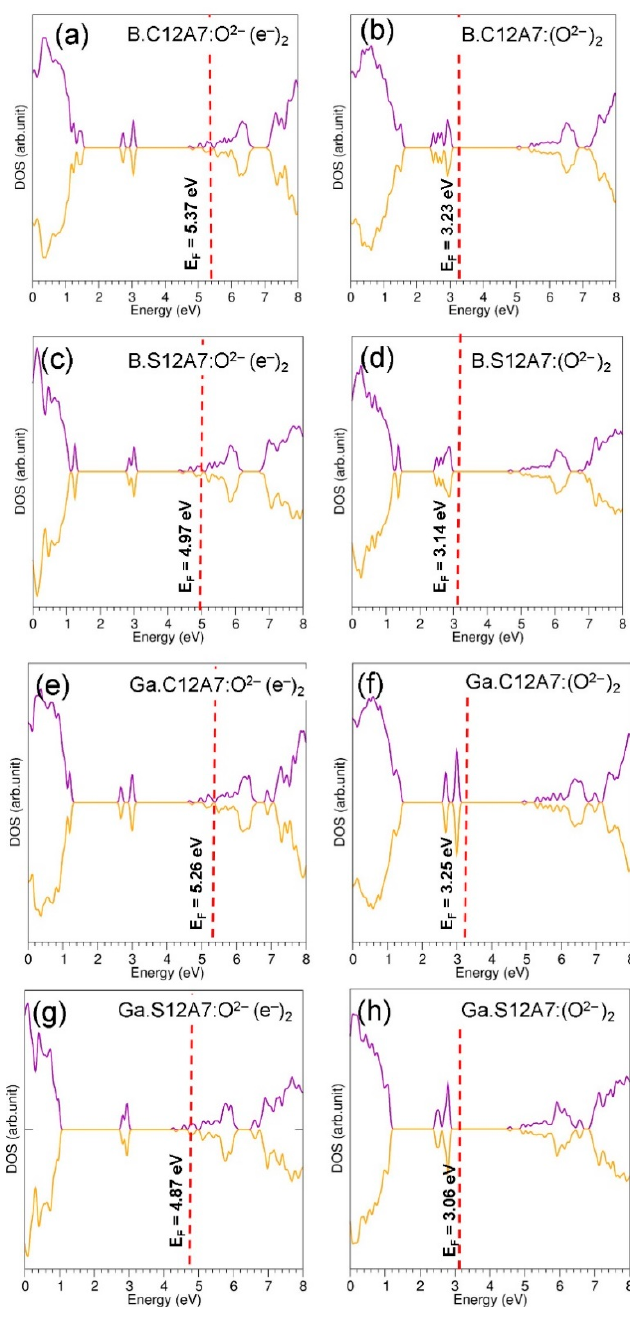
Figure 8. DOS plots for ( a ) B.C12A7:(e − ) 2 O 2 − , ( b ) B.C12A7:(O 2 − ) 2 , ( c ) B.S12A7:(e − ) 2 O 2 − , and ( d